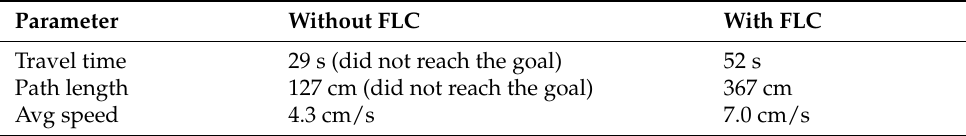
Table 2. Summarised test results of Experiment